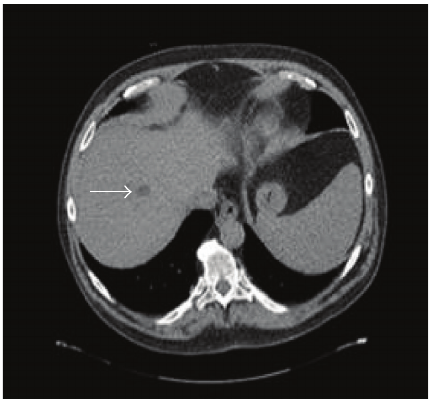
Figure 1: Multidetector CT of the abdomen on the day of admission showed a new ill-defined hypodense lesion in the right hepatic lobe.